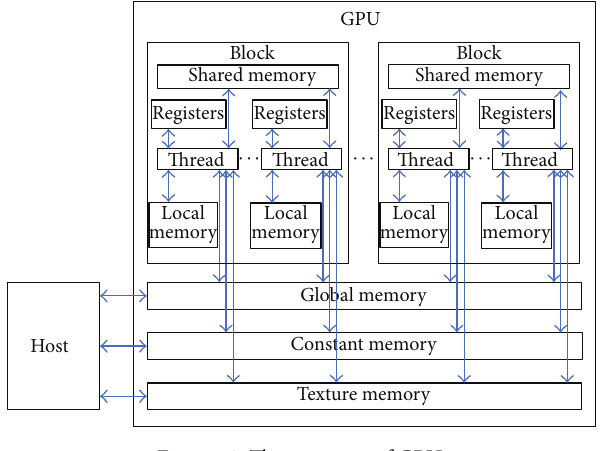
Figure 2: The structure of GPU.